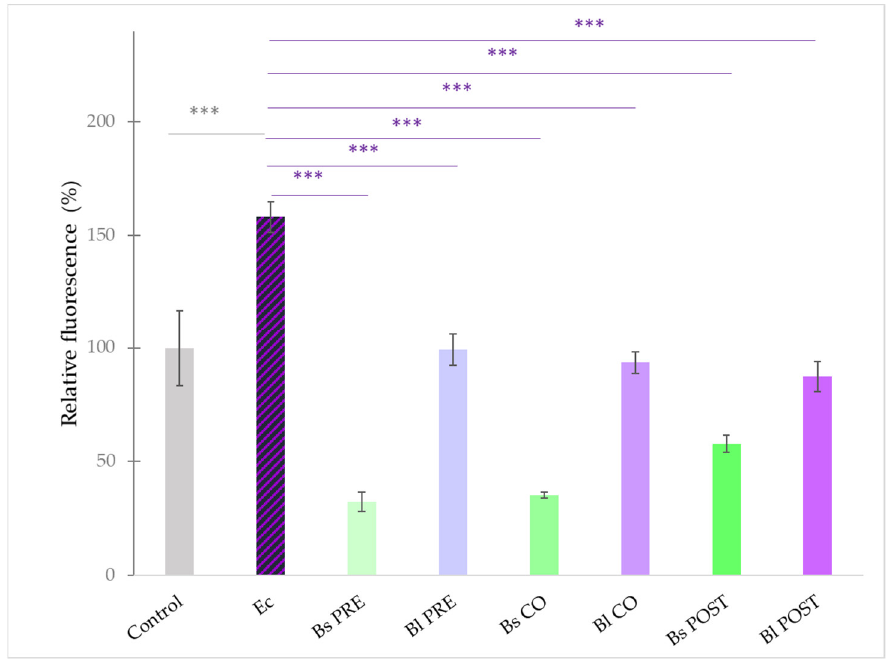
Figure 9. Amount of intracellular ROS after treatment with E. coli , B. licheniformis, and B. subtilis and their combinations. B. licheniformis and B. subtilis were added 1 h before (pre-treatment), at the same time as (co-treatment), or after (post-treatment) the addition of E. coli . Control : plain cell culture medium treatment; Ec : E. coli 10 6 CFU/mL; Bs PRE : pre-treatment with B. subtilis 10 8 CFU/mL + E. coli 10 6 CFU/mL; Bl PRE : pre-treatment with B. licheniformis 10 8 CFU/mL + E. coli 10 6 CFU/mL; Bs CO : co-treatment with B. subtilis 10 8 CFU/mL + E. coli 10 6 CFU/mL; Bl CO : co-treatment with B. licheniformis 10 8 CFU/mL + E. coli 10 6 CFU/mL; Bs POST : post-treatment with B. subtilis 10 8 CFU/mL + E. coli 10 6 CFU/mL; Bl POST : post-treatment with B. licheniformis 10 8 CFU/mL + E. coli 10 6 CFU/mL. Data are shown as means with standard deviations and expressed as relative fluorescence, consid- ering the mean value of control as 100%. n = 6/group. Significant difference: *** p ≤ 0.0001, in grey: compared with the untreated control. *** p ≤ 0.0001, in purple: compared with treatment with E. coli .